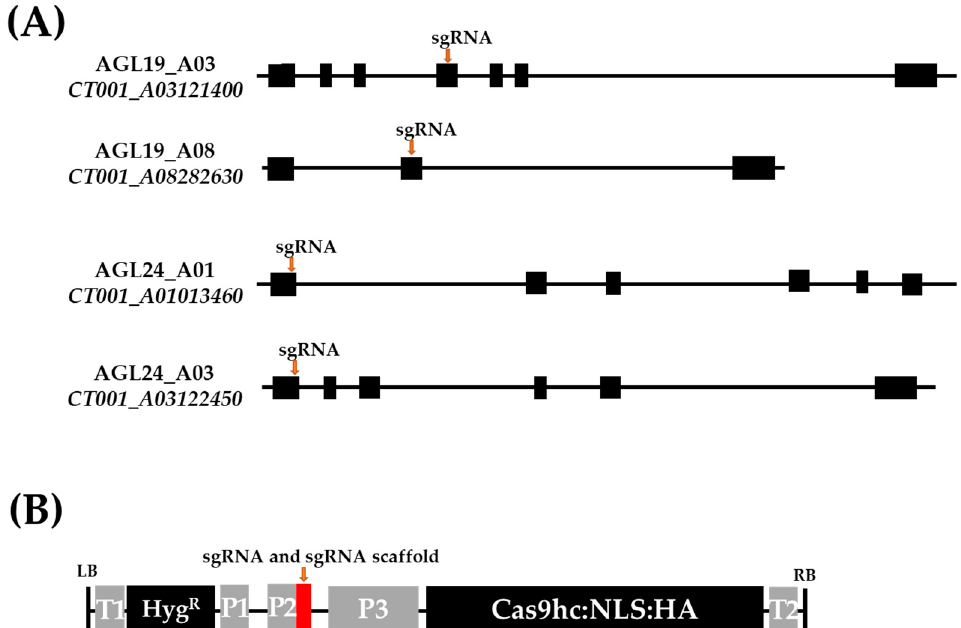
Figure 1. Gene structure analysis and construction of gene-editing vector. ( A ) Genomic structure of AGL and each homologous gene. Black box, exon regions; black line, intron regions; orange arrow, target site of single-guide RNAs (sgRNAs). ( B ) Schematic representation of the T-DNA in gene-editing vectors. LB, left border; T1, NOS terminator; Hyg R , hygromycin resistance gene; P1, NOS promoter; P2, Arabidopsis U6 promoter; P3, 35S promoter; Cas9hc:NLS:HA, human-codon-optimized Cas9 with the nuclear localization signal and an HA epitope; T2, 35S terminator; RB, right border. Red box, sgRNA and sgRNA